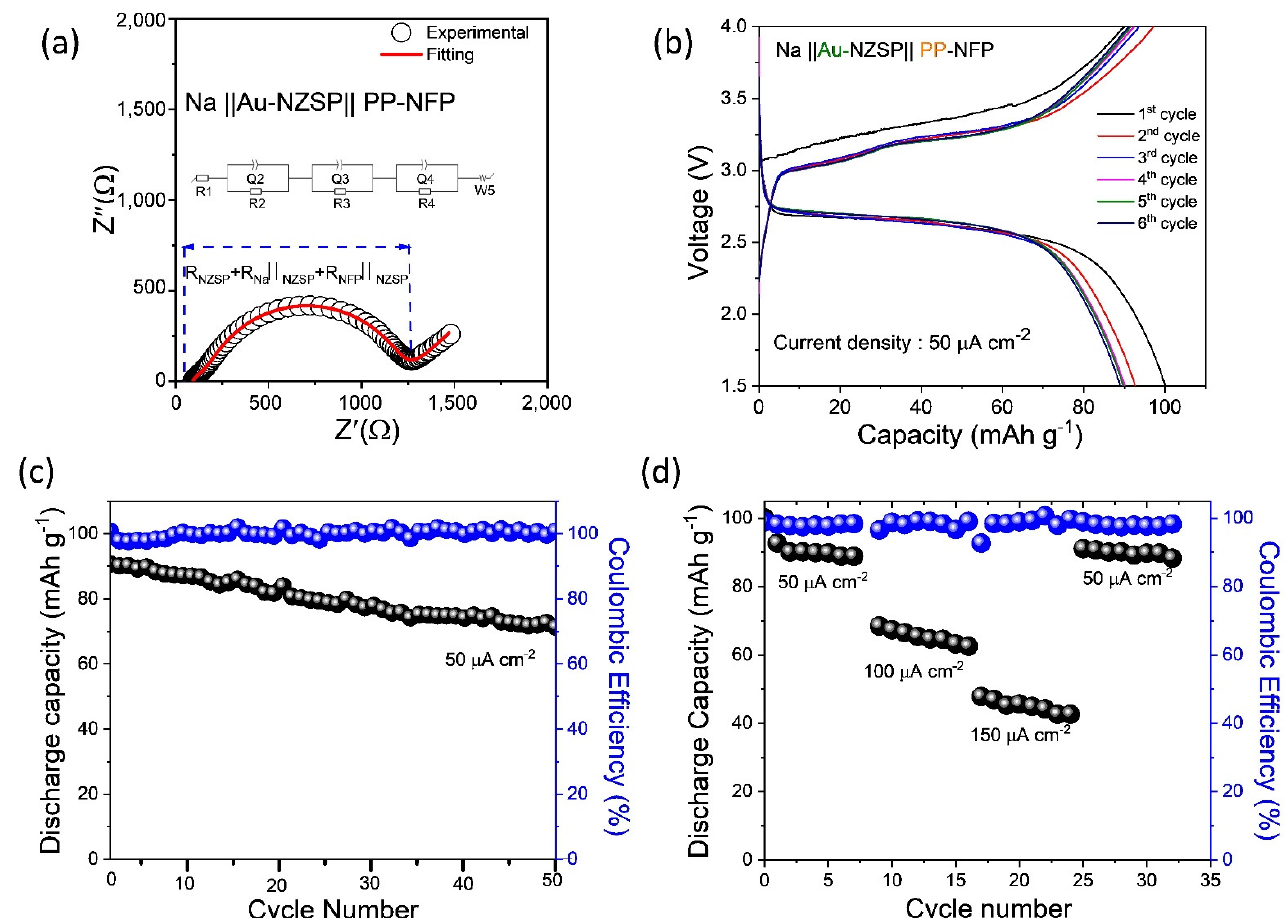
Figure 7. ( a ) Impedance plot of Na-Au||NZSP||PP-NFP; ( b ) charge–discharge curve of the Na-Au||NZSP||PP-NFP cell at 50 µA cm − 2 ; ( c ) cycling performance and Coulombic efficiency of the Na-Au||NZSP||PP-NFP at 50 µA cm − 2 ; and ( d ) rate capability test of the Na-Au||NZSP||PP-NFP cell at various current densities. All the measurements were performed at 25 °C.